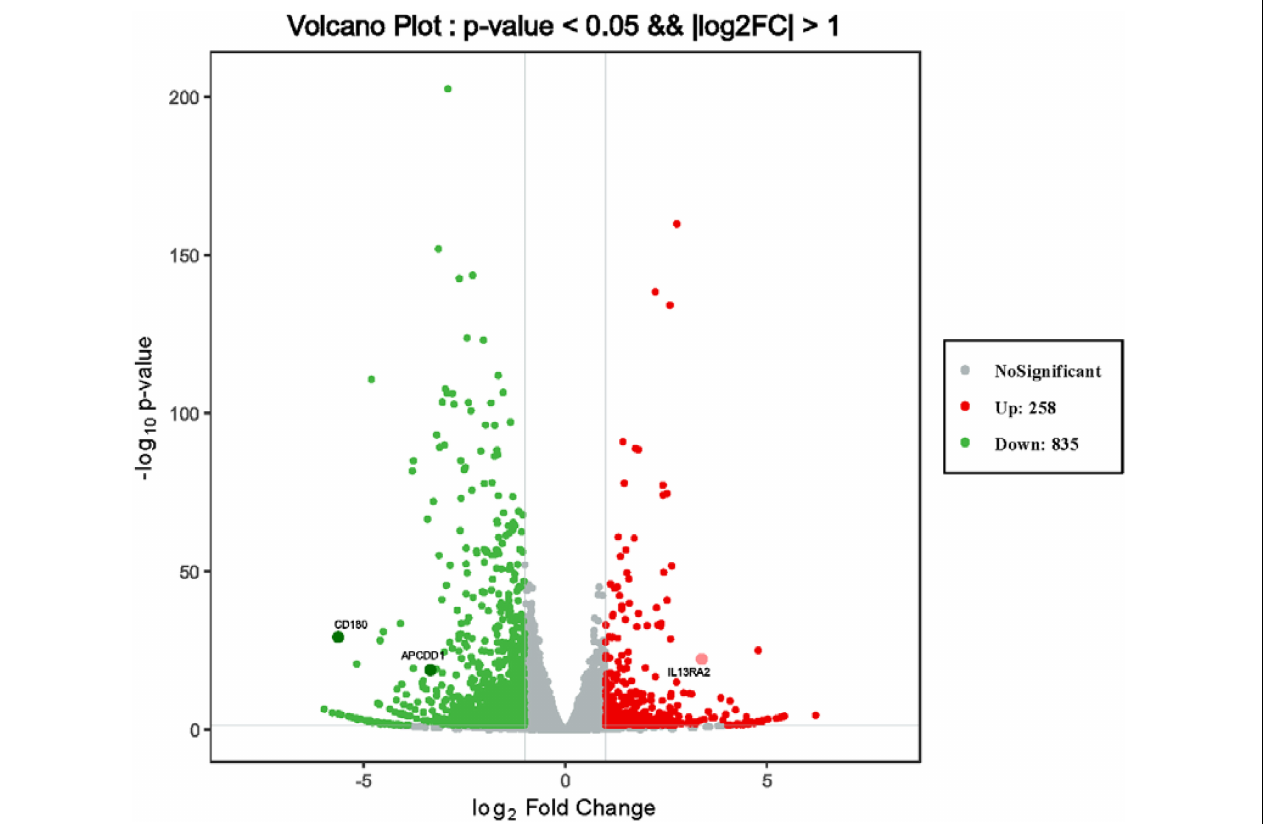
FIGURE 1 | Differentially expressed genes (DEGs) of retinal pigment epithelial (RPE) cells induced by the control group and vitreous. Results of a volcano plot chart of the differentially expressed genes were identified from the control and vitreous-treated